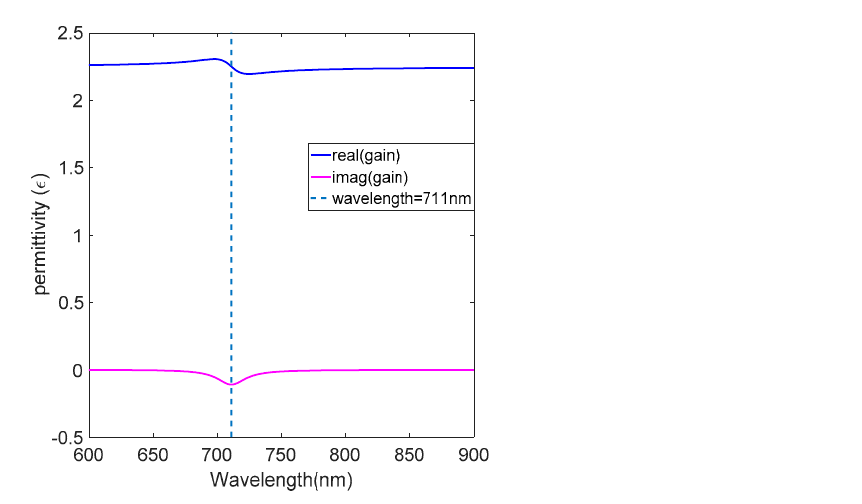
Figure 1. Cross − section of the Au/dye − doped fused silica multilayered metamaterial.